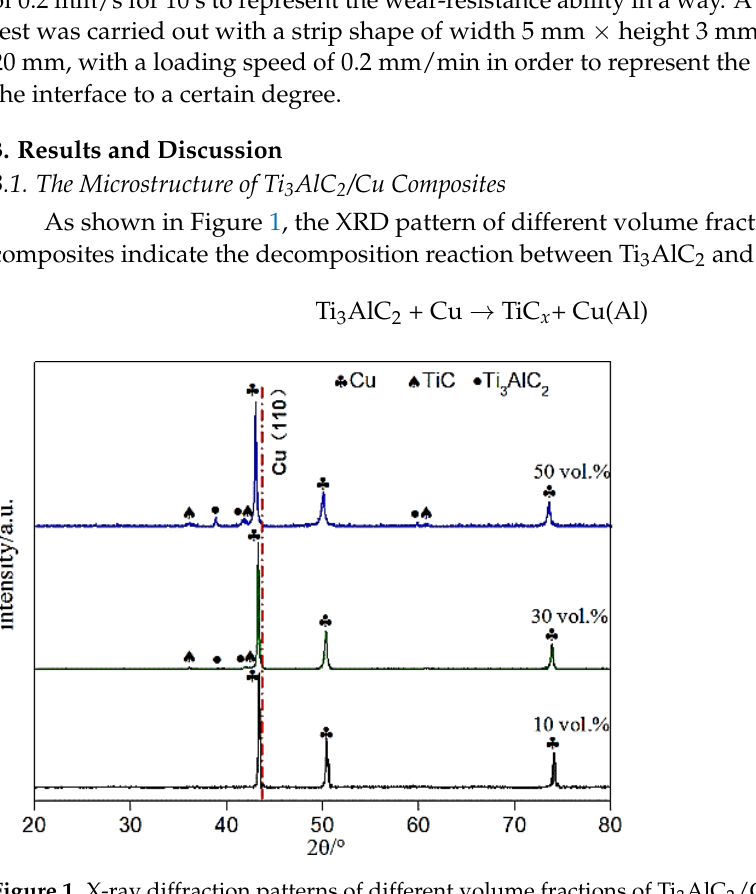
Figure 1. X-ray diffraction patterns of different volume fractions of Ti 3 AlC 2 /Cu matrix